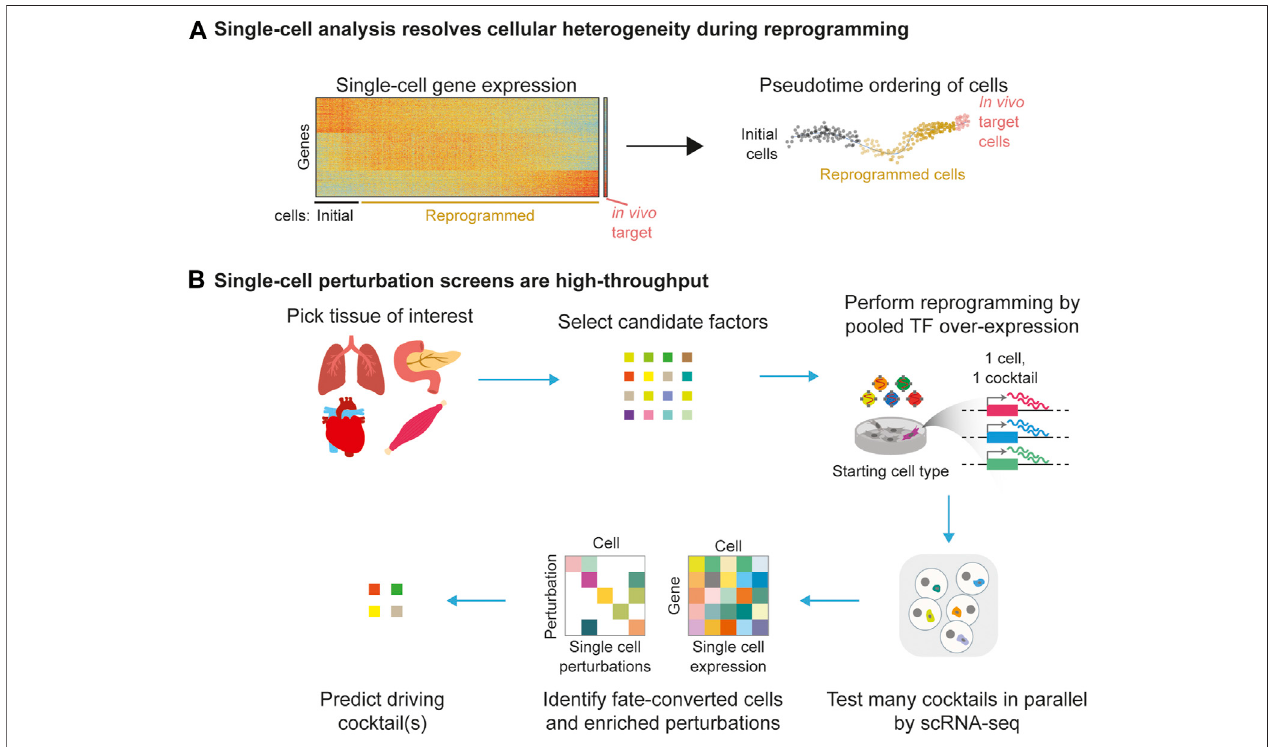
FIGURE 2 | Applications of single-cell genomics to cell fate engineering. (A) Single-cell analysis of reprogramming resolves cellular heterogeneity and reprogramming asynchrony. (B) Single-cell perturbation screens can scale the testing of reprogramming cocktails. Each sequenced cell tests a speci fi c cocktail, and sequencing thousands of cells allows many cocktails to be simultaneously tested in one